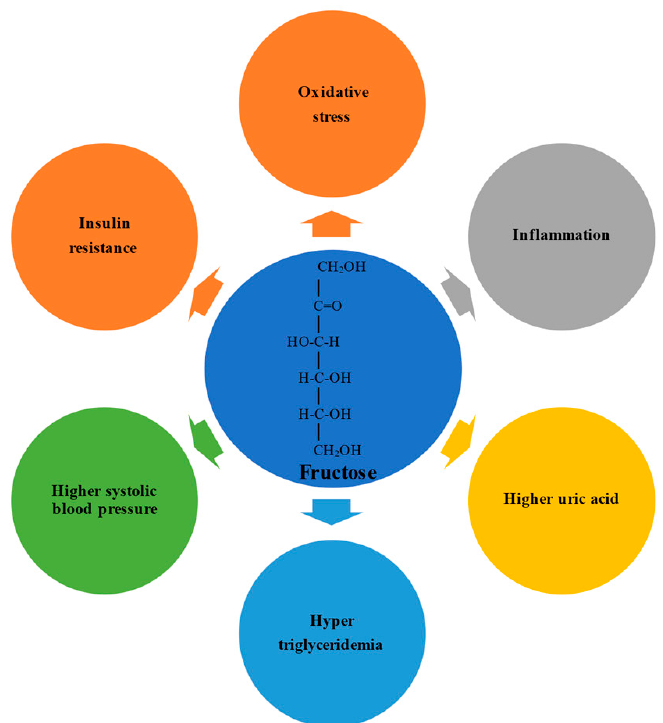
Figure 1. Systemic effects of overconsumption of fructose. Elevated fructose intake is implicated in increased oxidative stress, inflammation, higher uric acid levels, hypertriglyceridemia, higher systolic blood pressure, and insulin resistance, which are associated with the development or worsening of liver diseases.